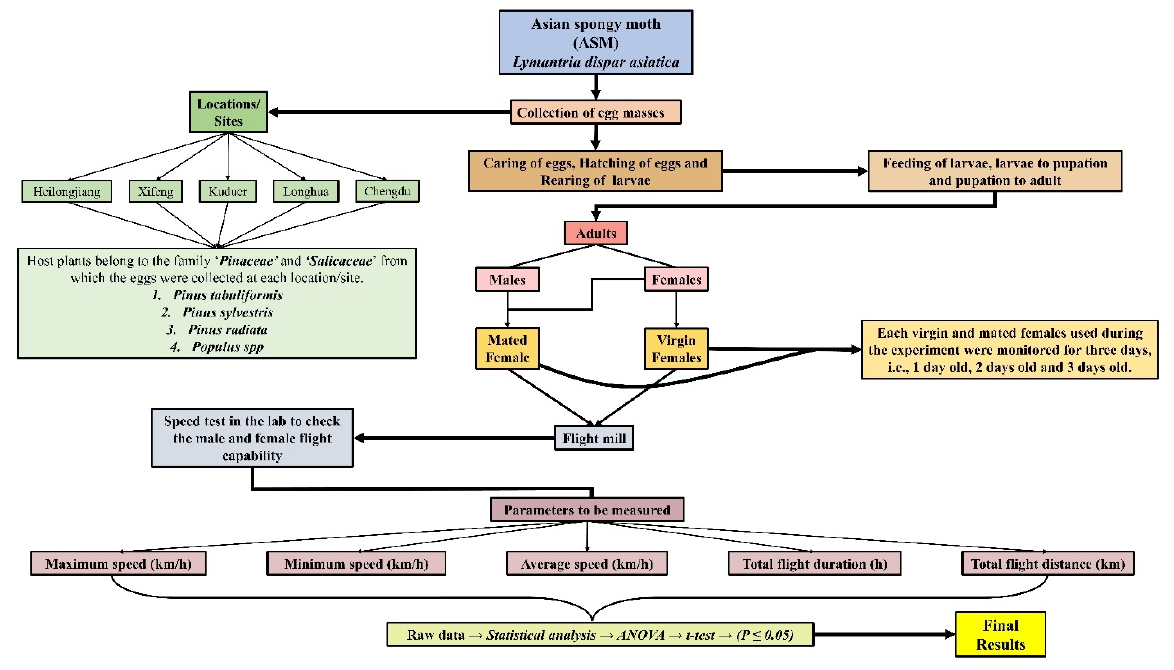
Figure 1. Conceptual framework of the present study.